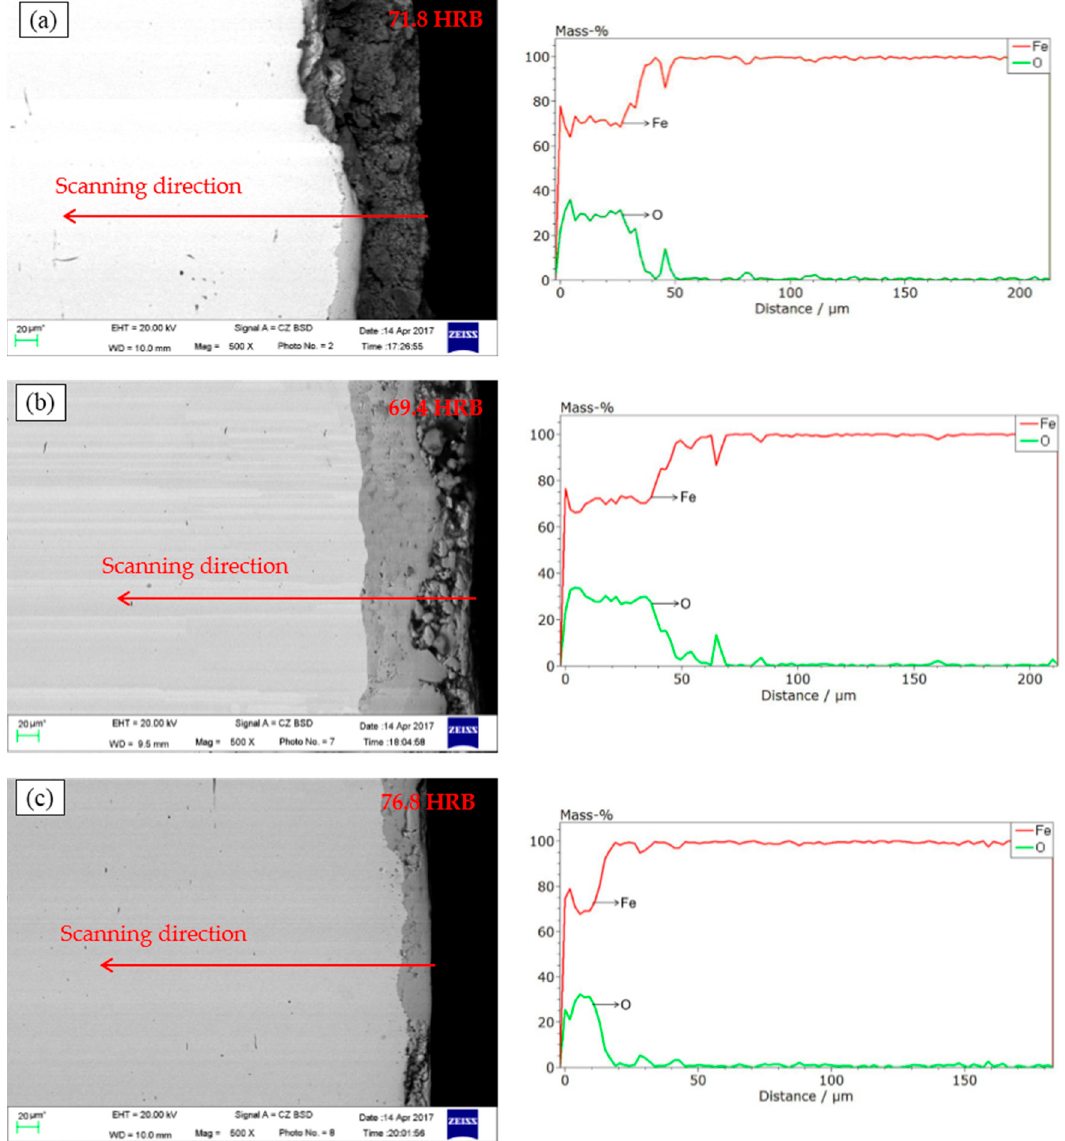
Figure 7. SEM images and EDS spectra of oxide scales of hot-rolled strips lubricated with ( a ) non-lubricant; ( b ) traditional lubricating fluid and ( c ) nano-TiO 2